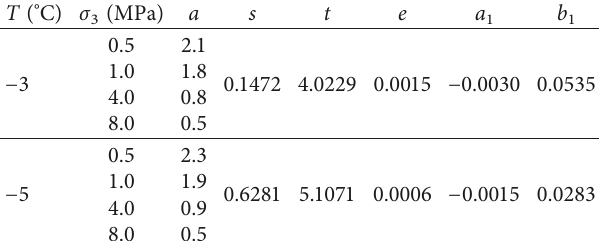
Table 2: Parameters related to the volume tangent modulus μ